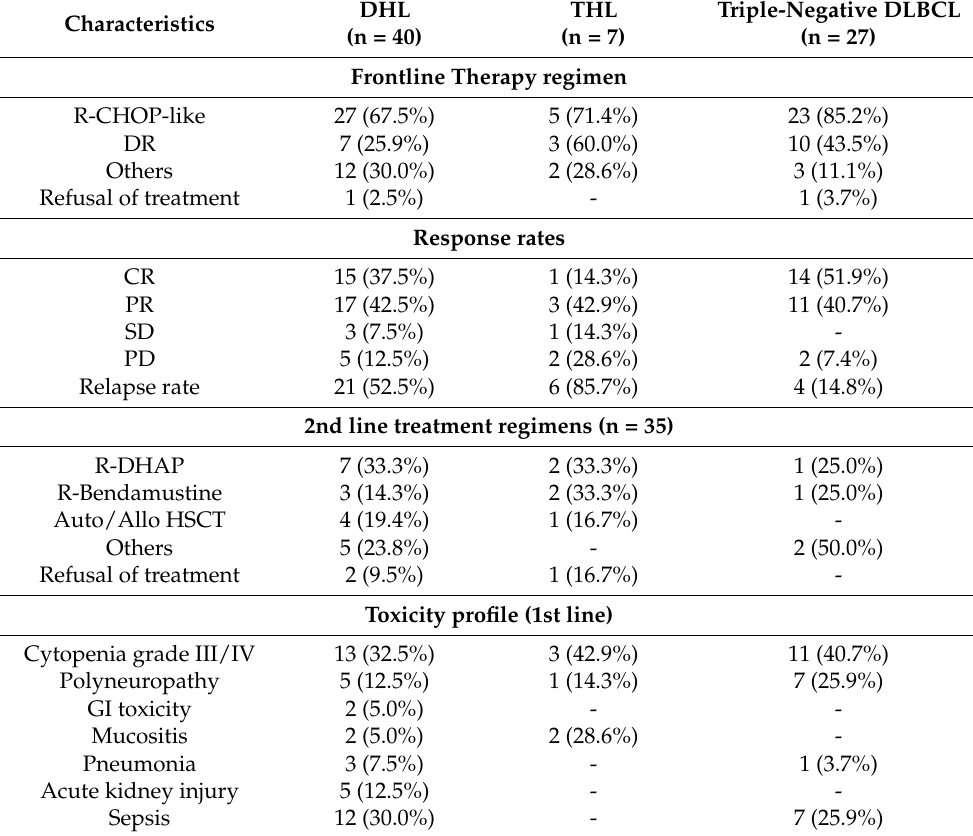
Table 2. Treatment modalities of the study